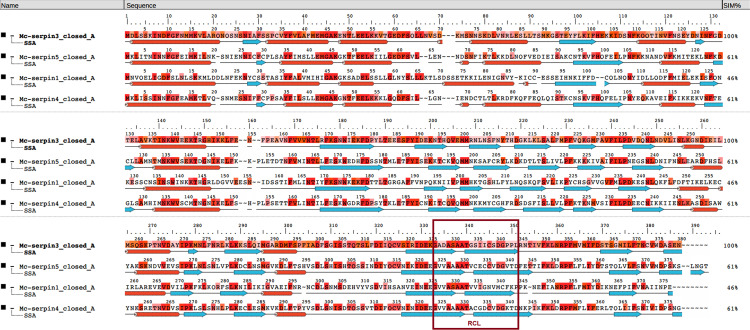
Structure-based amino acid sequence alignment of the closed form of Myxobolus cerebralis serpins Mc-S1, Mc-S3, Mc-S4 and Mc-S5.RCL: reactive center loop.